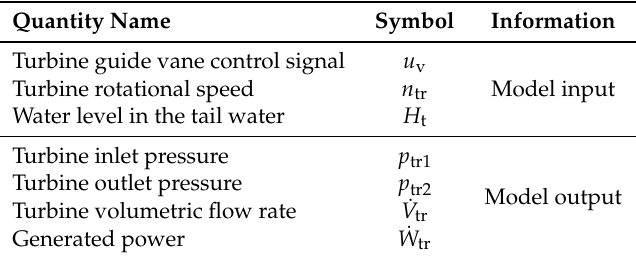
Table 3. Measured quantities.